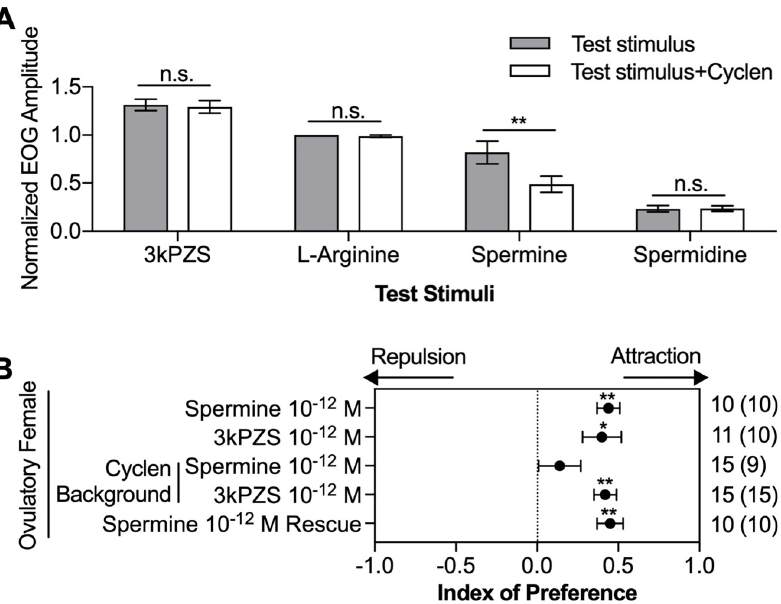
Fig 5. Cyclen impeded spermine-induced olfactory and behavioral responses. (A) Cyclen treatment (10 − 5 M) reduced the EOG response magnitude to spermine (10 − 5 M) but not to 3kPZS (10 − 7 M), spermidine (10 − 5 M), or L - arginine (10 − 5 M). EOG responses were blank-subtracted and normalized to the amplitude of the responses to 10 − 5 M L -arginine (mean ± SEM, n = 5). The difference in responses for each stimulus before (gray) and during (white) exposure of the naris to cyclen was evaluated with a paired t test. (B) Ovulatory female sea lamprey behavioral responses to spermine and 3kPZS (positive control) in the absence and presence of 10 − 12 M cyclen (cyclen background) in a two-choice maze assay (S2 Fig). The effect of cyclen was reversible because the attraction to spermine was rescued when cyclen application ceased. For the definition of the index of preference, see Materials and methods. A positive index value indicates attraction, and a negative index value indicates repulsion. Significance was evaluated using a Wilcoxon signed-rank test. The number in the parentheses indicates the number of test subjects spending more time in the experimental channel out of the total sample size. � p < 0.05, �� p < 0.01. Underlying data are available in S1 Data. EOG, electro-olfactogram; n.s., not significant; 3kPZS, 3-keto petromyzonol sulfate.